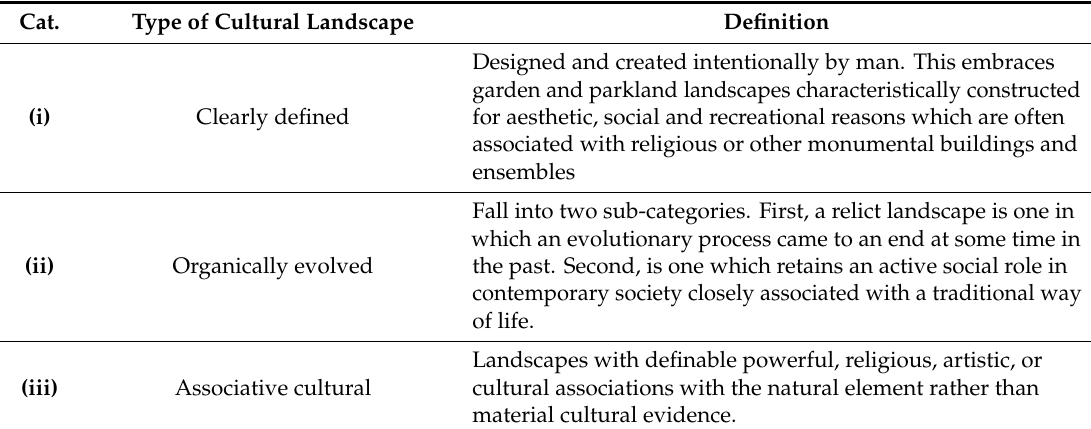
Table 3. UNESCO Categories for Cultural